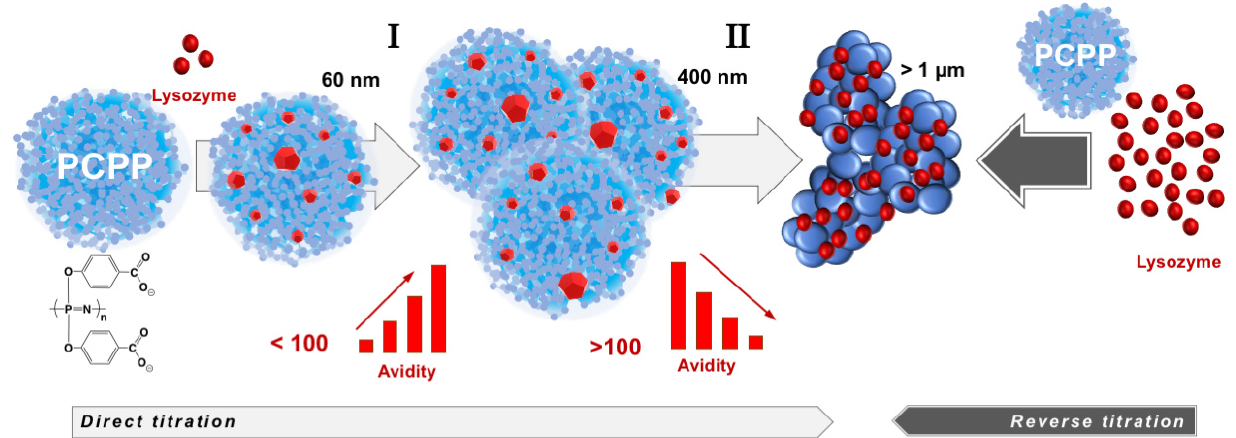
Figure 5. Lysozyme self-assembles onto PCPP with the formation of multimeric nano-scale, submi- cron size complexes and micron size aggregates with avidity varying as the self-assembly process proceeds (the drawings of complexes and aggregates are not to scale).